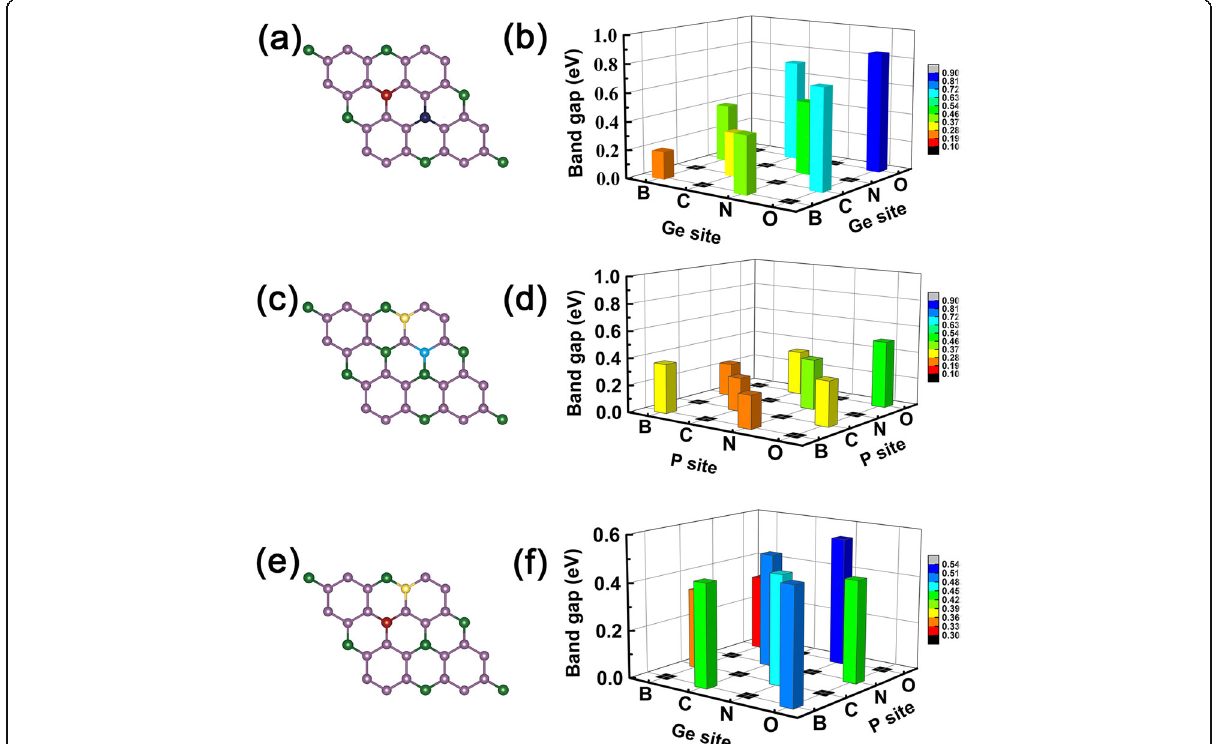
Fig. 7 Band gaps of all co-doped systems. The magnitude of band gaps of co-doped GeP 3 monolayer, the lefts are the sketch of co- doped sites, and the rights are the magnitude of band gaps corresponding to the doping elements. a , b The case for doping elements occupy the two Ge atoms. c , d The case for doping elements occupy the two P atoms. e , f The case for doping elements occupy the Ge and P atoms,